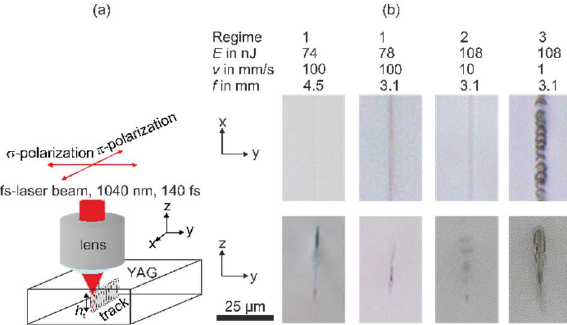
Fig. 1. Light microscope images of fs-laser written tracks inscribed in [111]-direction with π-polarization and the f = 3.1 mm lens, and σ-polarization with the f = 4.5 mm lens.